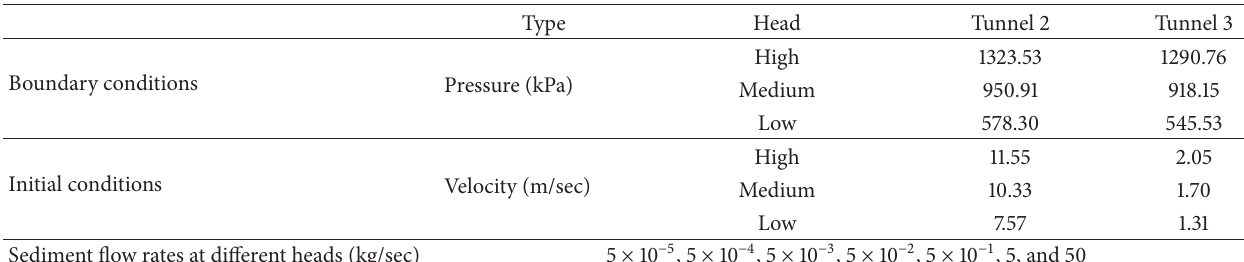
Table 6: Boundary conditions, initialization condition, and sediment flow rates at different heads.